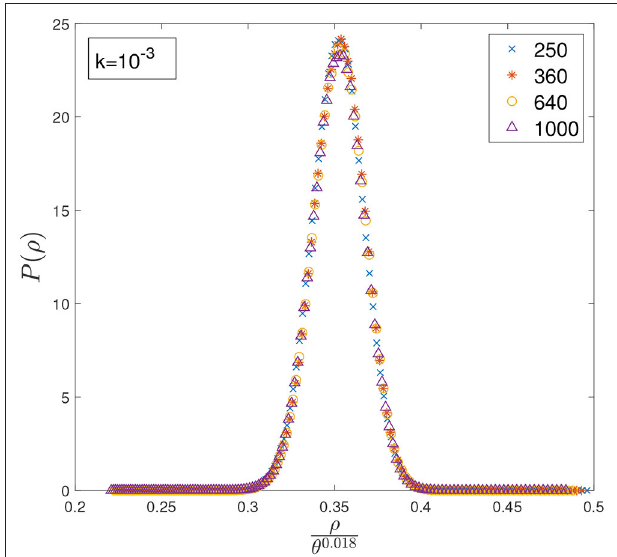
FIGURE 1 | Distribution of densities P ( ρ ) computed at different values of θ and fixed L = 1,000. The x-axis has been rescaled by θ 0.02 to align the peaks.